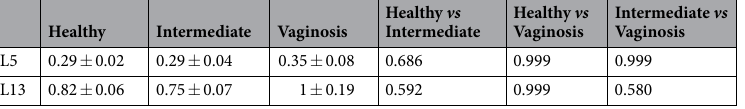
Table 5. Soluble immune factors related to changes of the microbial composition. Data are shown as the mean value (pg/mL) ± standard error of mean. Comparisons between groups were performed using a nonparametric Kruskal-Wallis test. The p values are adjusted for multiple